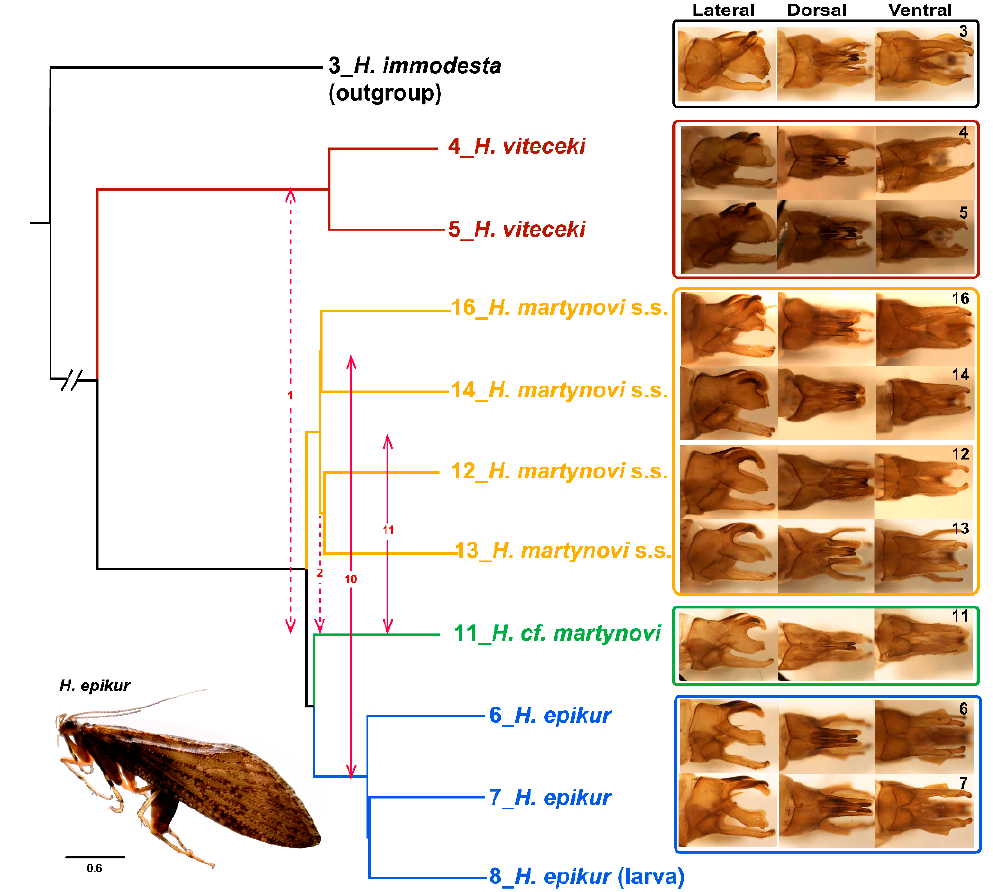
Figure 4. Gene flow and morphological variation of the genitals among the Himalopsyche species showing on the species tree. The species tree is calculated by ASTRAL-III based on 691 gene trees constructed with maximum likelihood. Different colors show the phylogenetic position among the same species. Gene flow are calculated by ExoDfoil. Two-way arrows depict bidirectional gene flow signal, one-way arrows depict unidirectional gene flow signal, numbers inside arrows represent the frequency of significant gene flow signals. Different thickness of the solid arrows shows different gene flow frequency, dashed red lines indicate low gene flow frequency. H. martynovi s.s. is the abbreviation of H. martynovi sensu stricto. Numbers on the images are corresponding with the sample ID.